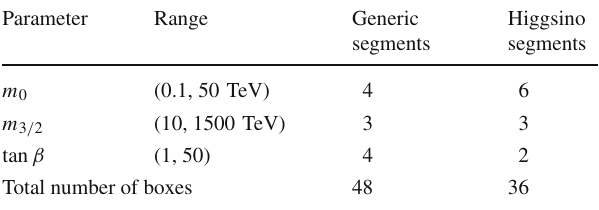
Table 1 Ranges of the mAMSB parameters sampled, together with the numbers of segments into which each range was divided, and the corresponding number of sample boxes. The numbers of segments and boxes are shown both for the generic scan and for the